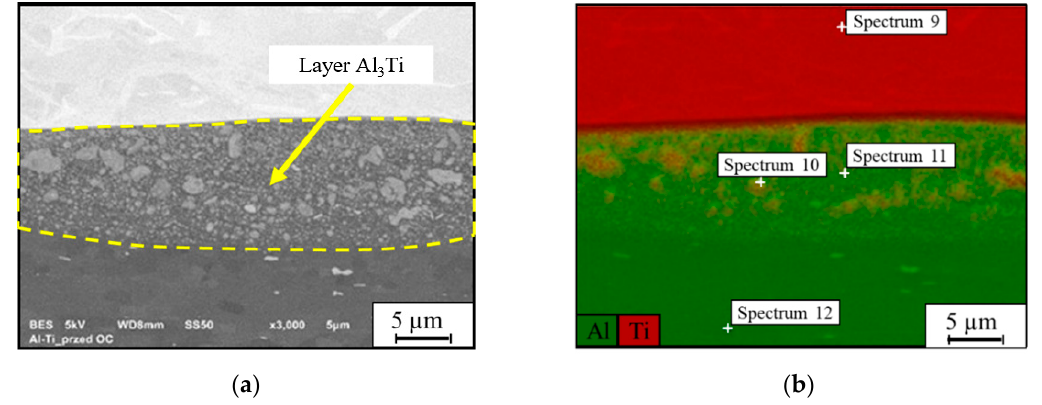
Figure 3. Micro-area of the AA1050-AA2519 material connection zone: ( a ) microstructure, ( b ) chemical composition measurement locations.